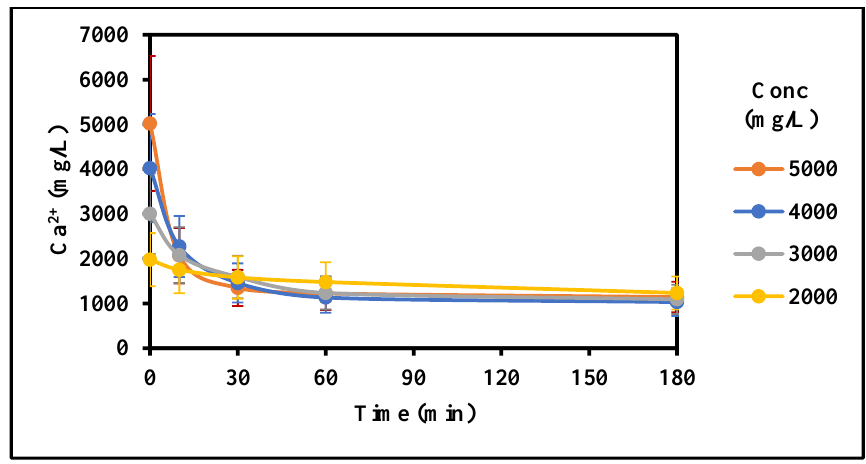
Figure 2. Effect of concentration on the rate of gypsum crystallization (2000–5000 mg/L CaSO 4 (as Ca), 5 g/L gypsum seed, 0 g/L Fe 3+ , 0 mg/L Inh, 25 °C, stirring rate: 200 rpm; Stirring time (min): 180/180).-